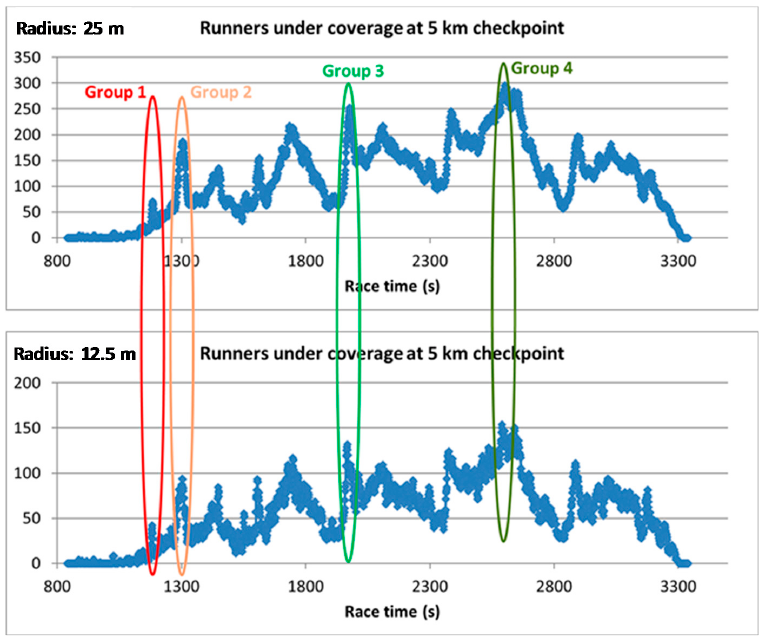
Figure 4. Runners under coverage at 5 km checkpoint for different coverage radii.